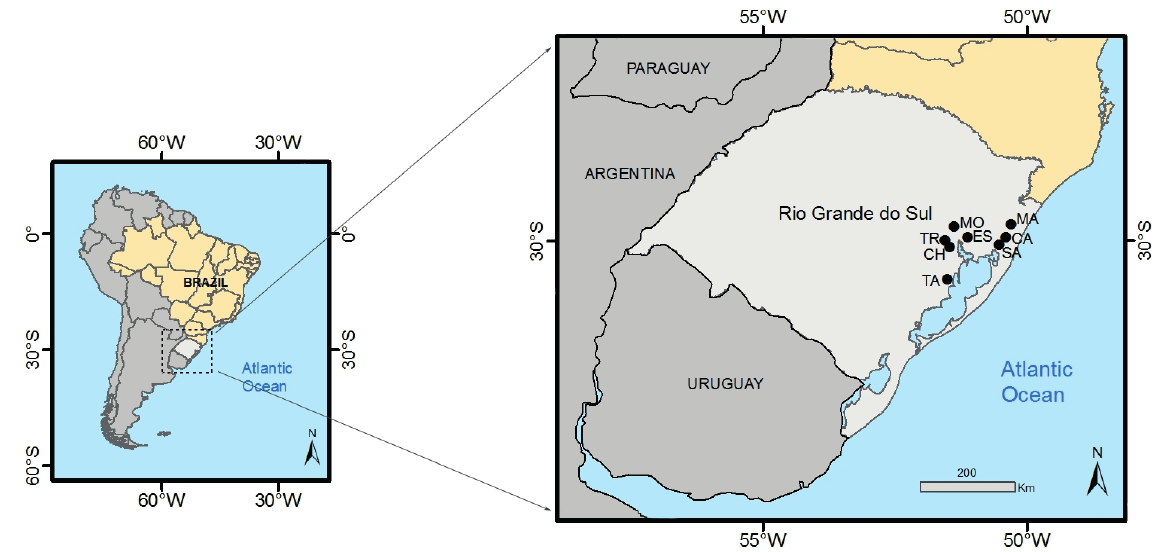
Figure 1 - Location of the seven monitored cities (CA, MA, SA, CH, TR, ES and MO) and the city where lichen samples of Parmotrema tinctorum were collected (TA) to be later exposed to monitor air pollution. Abbreviations: CA = Caraá; MA = Maquiné; SA = Santo Antônio da Patrulha; CH = Charqueadas; TR = Triunfo; ES = Esteio; MO = Montenegro; TA =